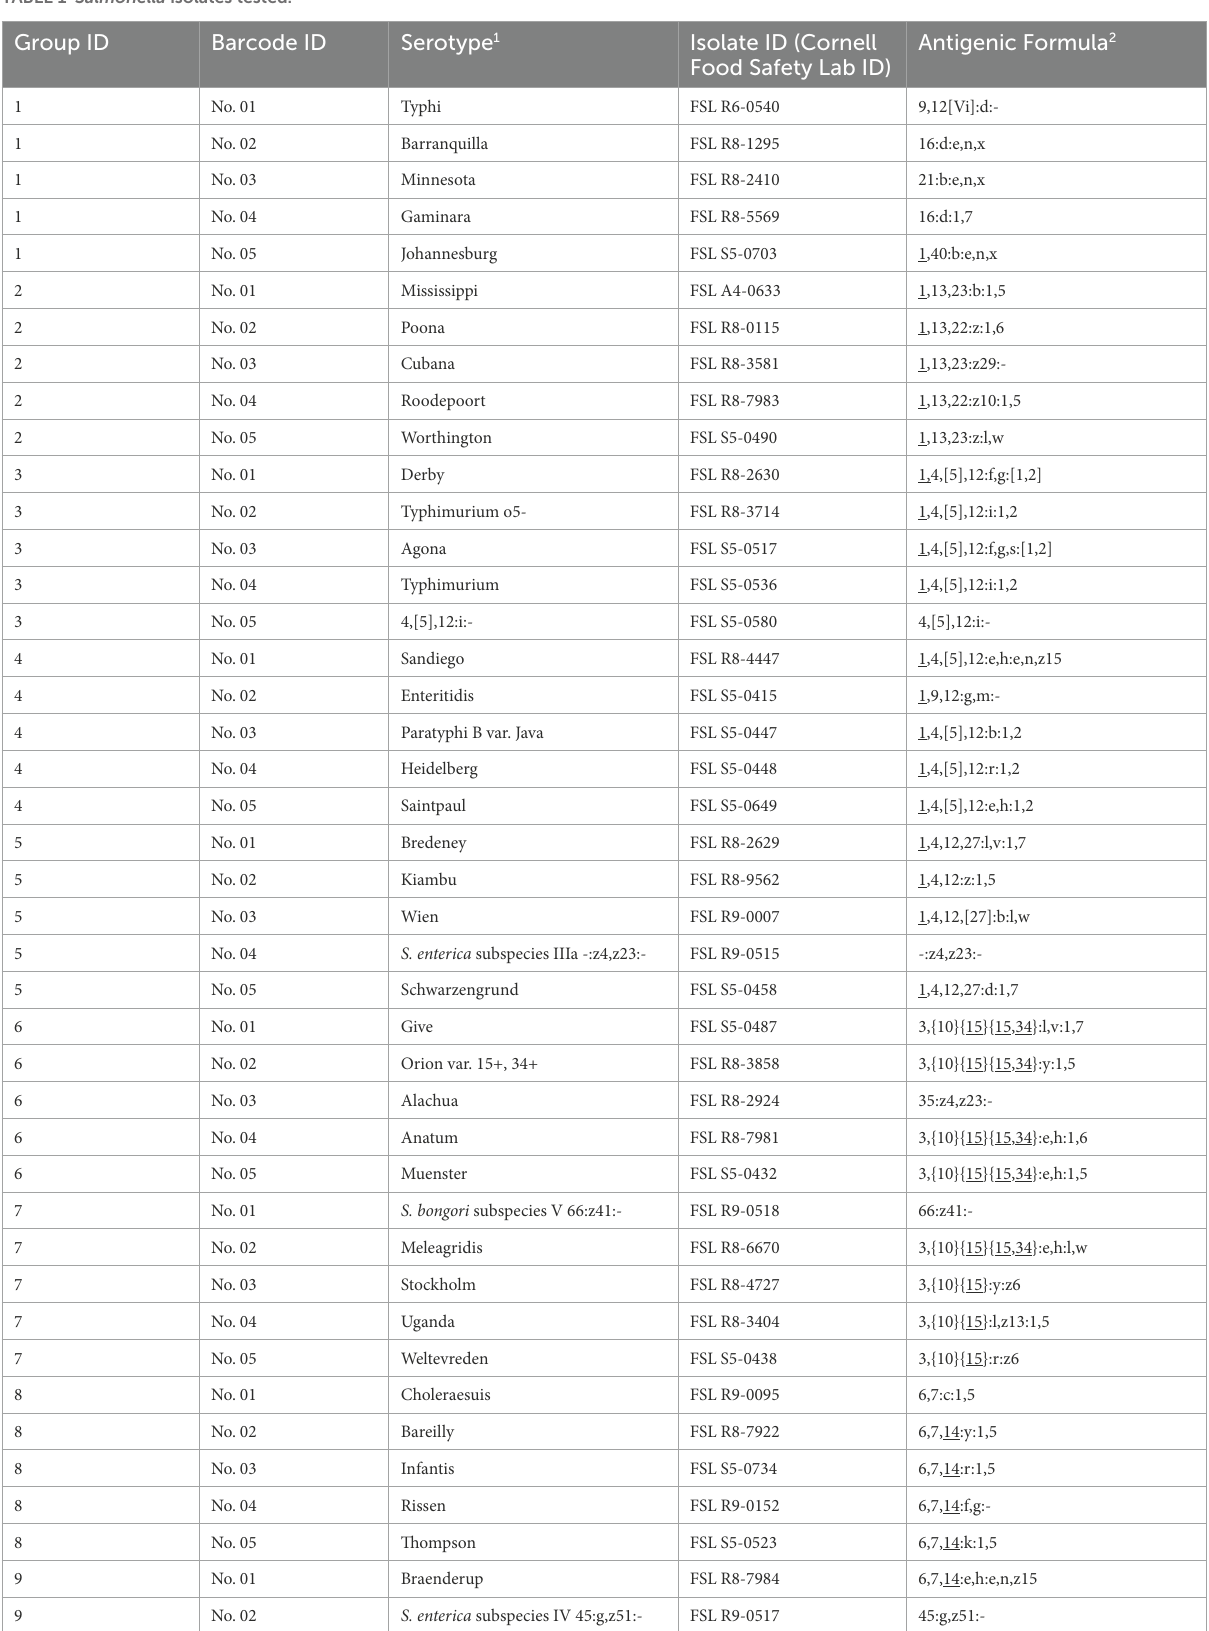
TABLE 1 Salmonella isolates